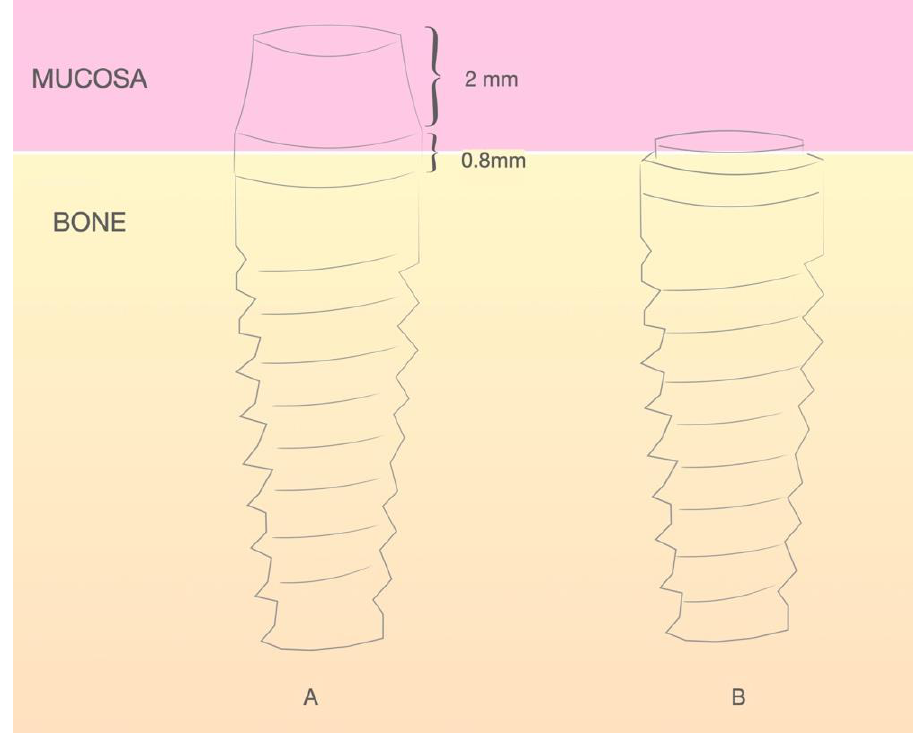
Figure 3 . ( A ) ubication of the PRAMA implant with respect to the peri-implant tissue. ( B ) ubi- cation of the KHONO implant with respect to the peri-implant tissue.